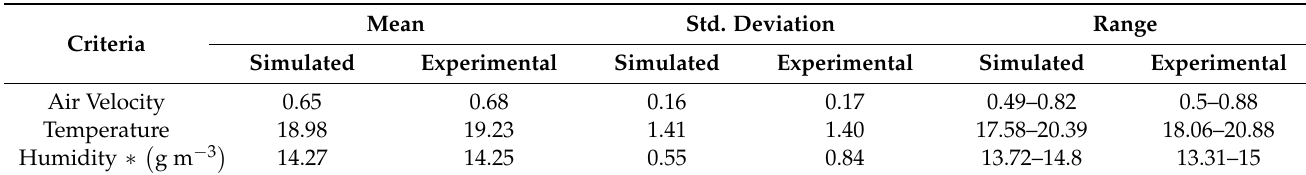
Table 6. Simulated and experimental statistics for air velocity, temperature, and humidity at a height of 1.7 m. Mean Std. Deviation Range Criteria Simulated